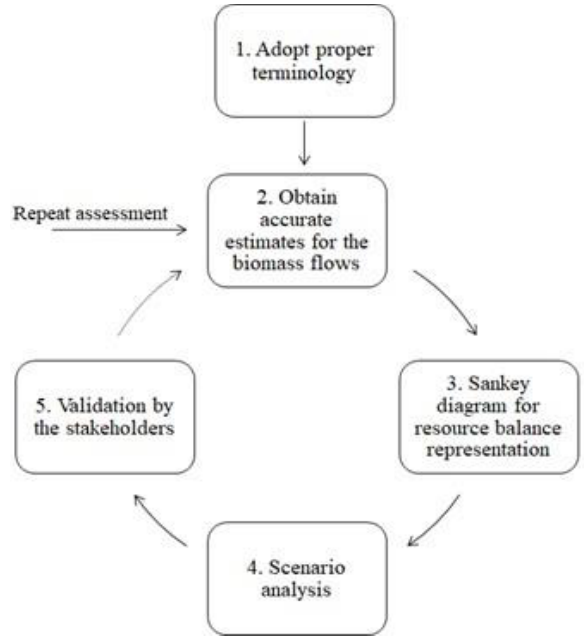
Figure 2. Five-step methodological approach for wood-based biomass material flow analysis.